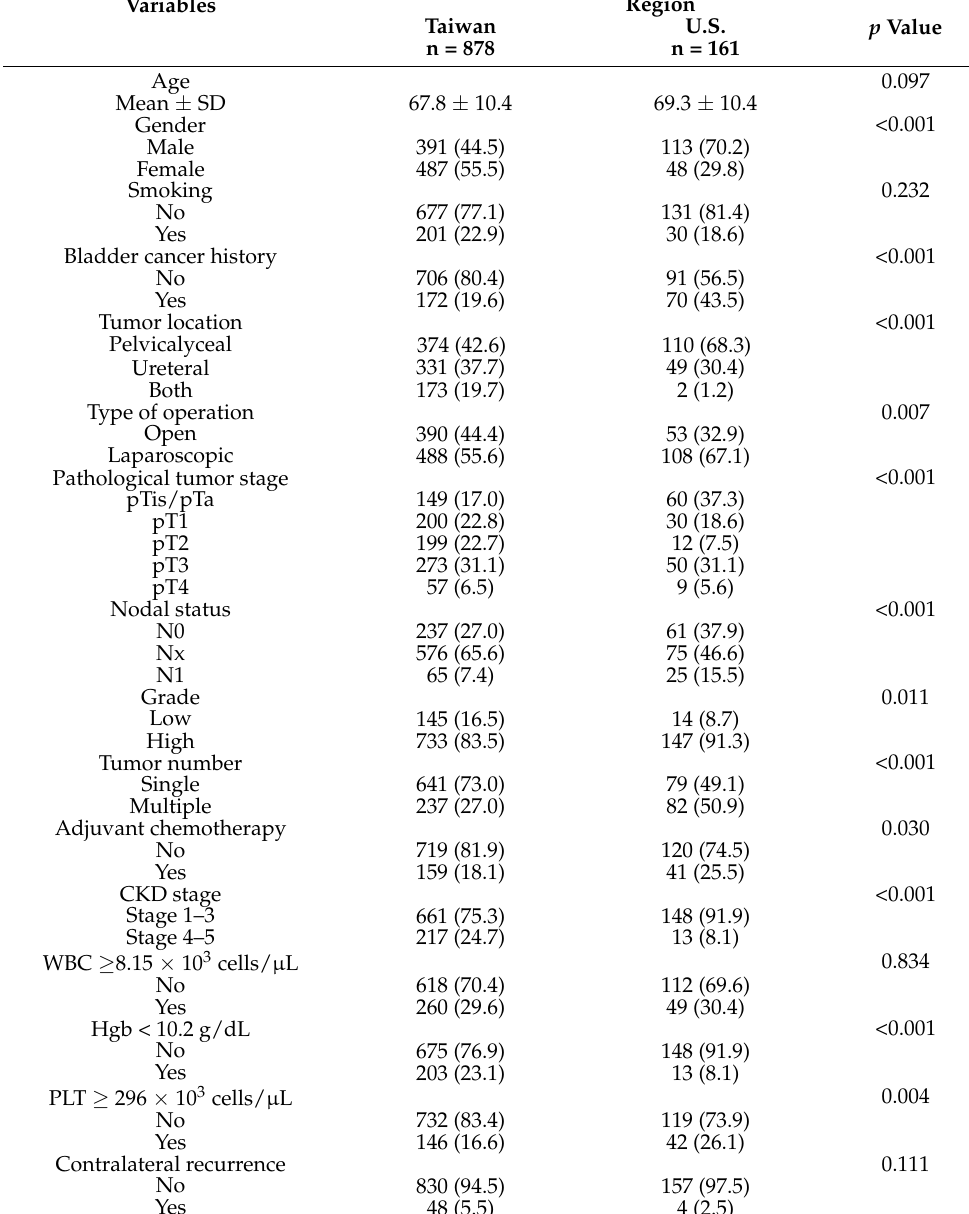
Table 2. Demographics and clinicopathologic characteristics of the 1039 patients with UTUC accord- ing to region of